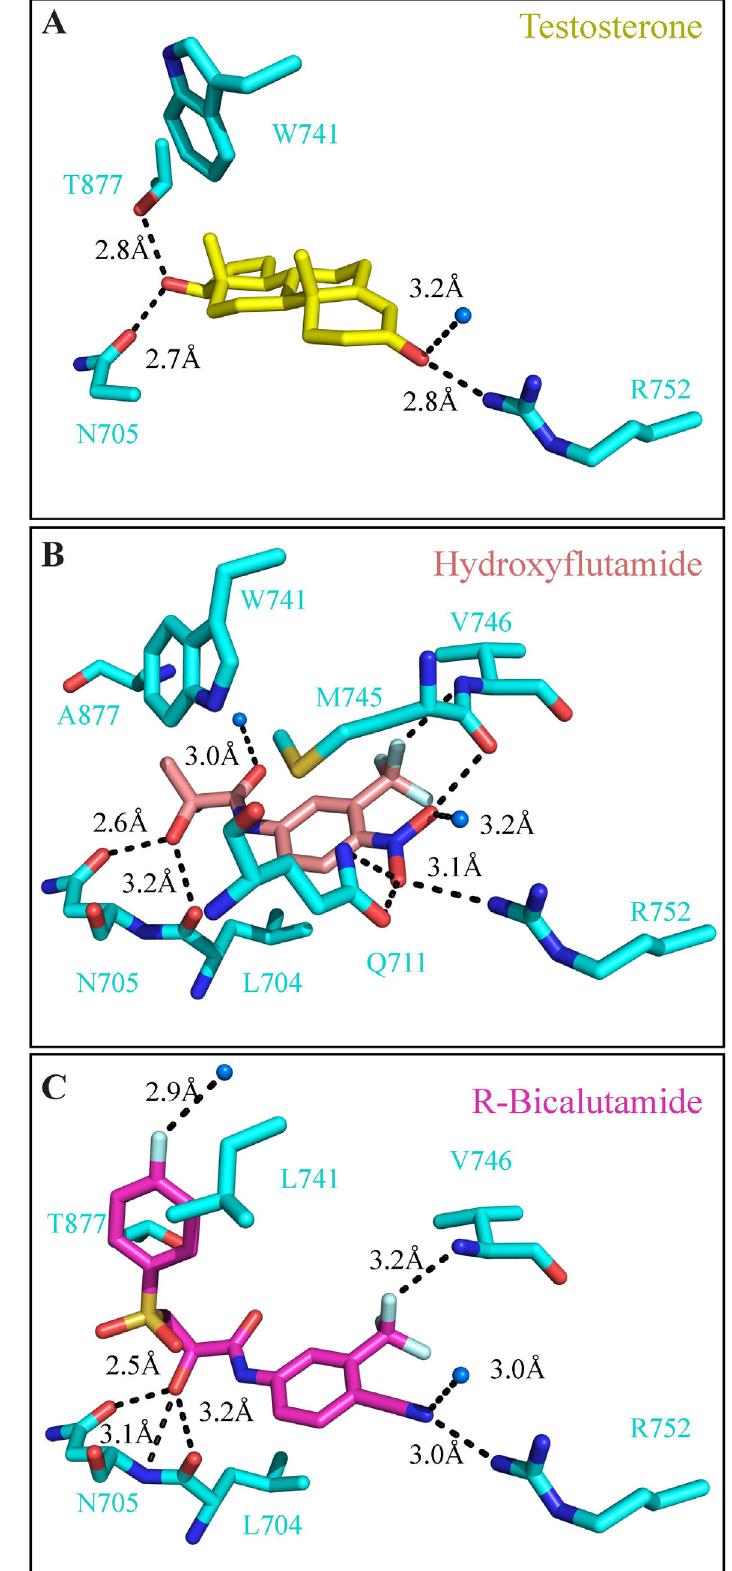
Figure 4. Detailed view of the androgen binding site in complex with ( A ) testosterone, ( B ) hydroxyflutamide and ( C ) R-bicalutamide. The hydrogen bonds and ionic interactions between the protein and the ligand are shown as dashed